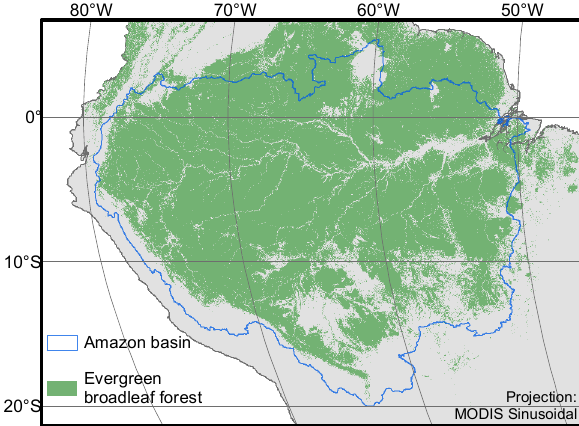
Figure 1: Study Area (land boundaries based on data set of Bjorn Sandvik